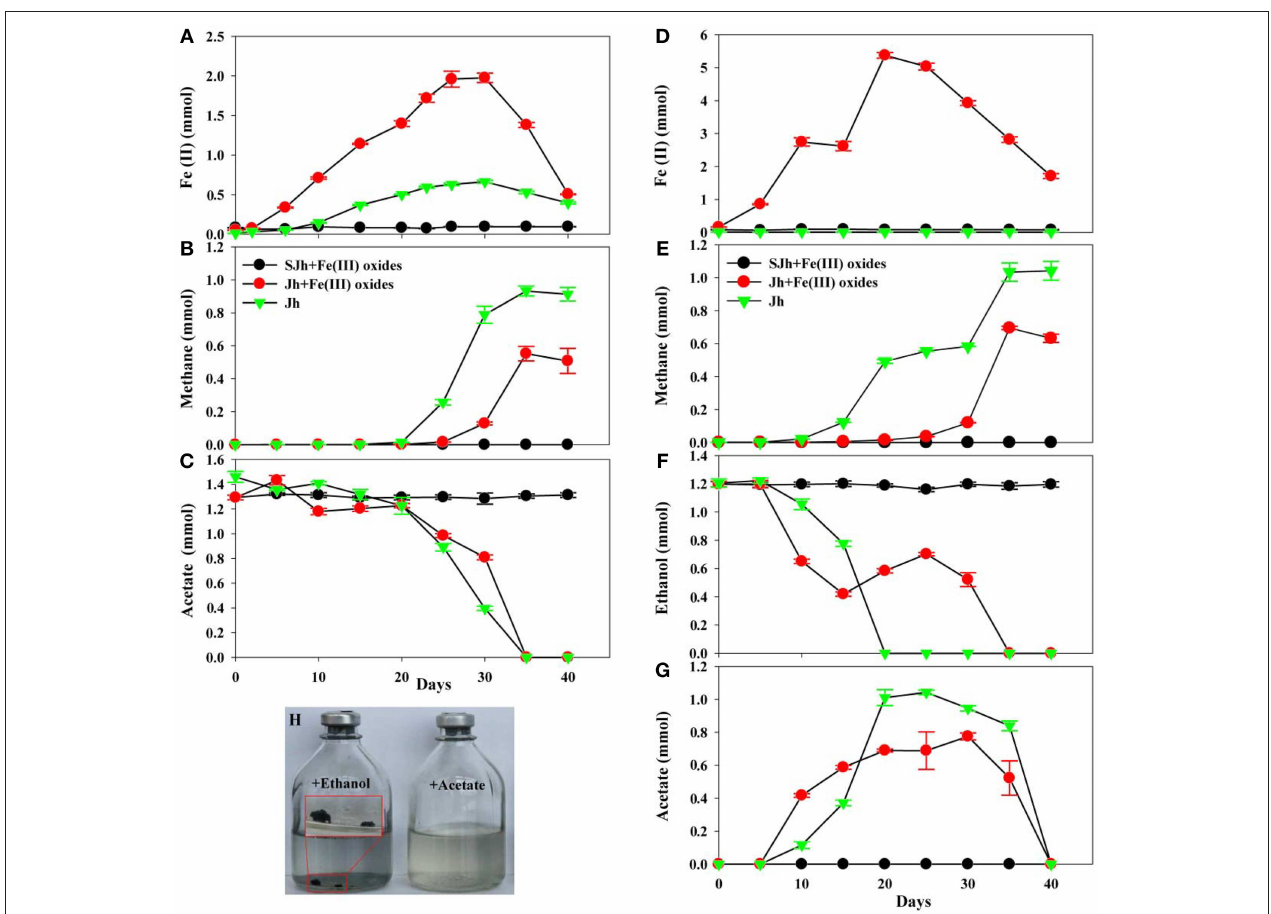
FIGURE 3 | Fe(III) reduction, methane production and acetate or ethanol consumption of enrichment cultures. Time-courses of Fe(II) production (A) , methane production (B) and acetate consumption (C) in enrichment cultures by 10% (w/v, wet) inoculation from fresh water enrichment culture of in situ sediments with 33mmol L − 1 of acetate in the absence or presence of 100mmol L − 1 of Fe(III) oxides. Time-courses of Fe(II) production (D) , methane production (E) , ethanol consumption (F) and acetate production/consumption (G) in enrichment cultures by 10% (v/v) inoculation from enrichment culture of three transfers of in situ sediments in DSM 120 medium with 30mmol L − 1 of ethanol in the absence or presence of 100mmol L − 1 of Fe(III) oxides. (H) Image was presented aggregates after enrichment culture in DSM 120 medium with ethanol or acetate as a substrate in the absence of Fe(III) oxides. Sterile sediment sample (SJh) with Fe(III) oxides treatment was used as the negative control. Data was presented in triplicate and standard deviation was shown for each data point. Jh2 was selected as the representative sample named as